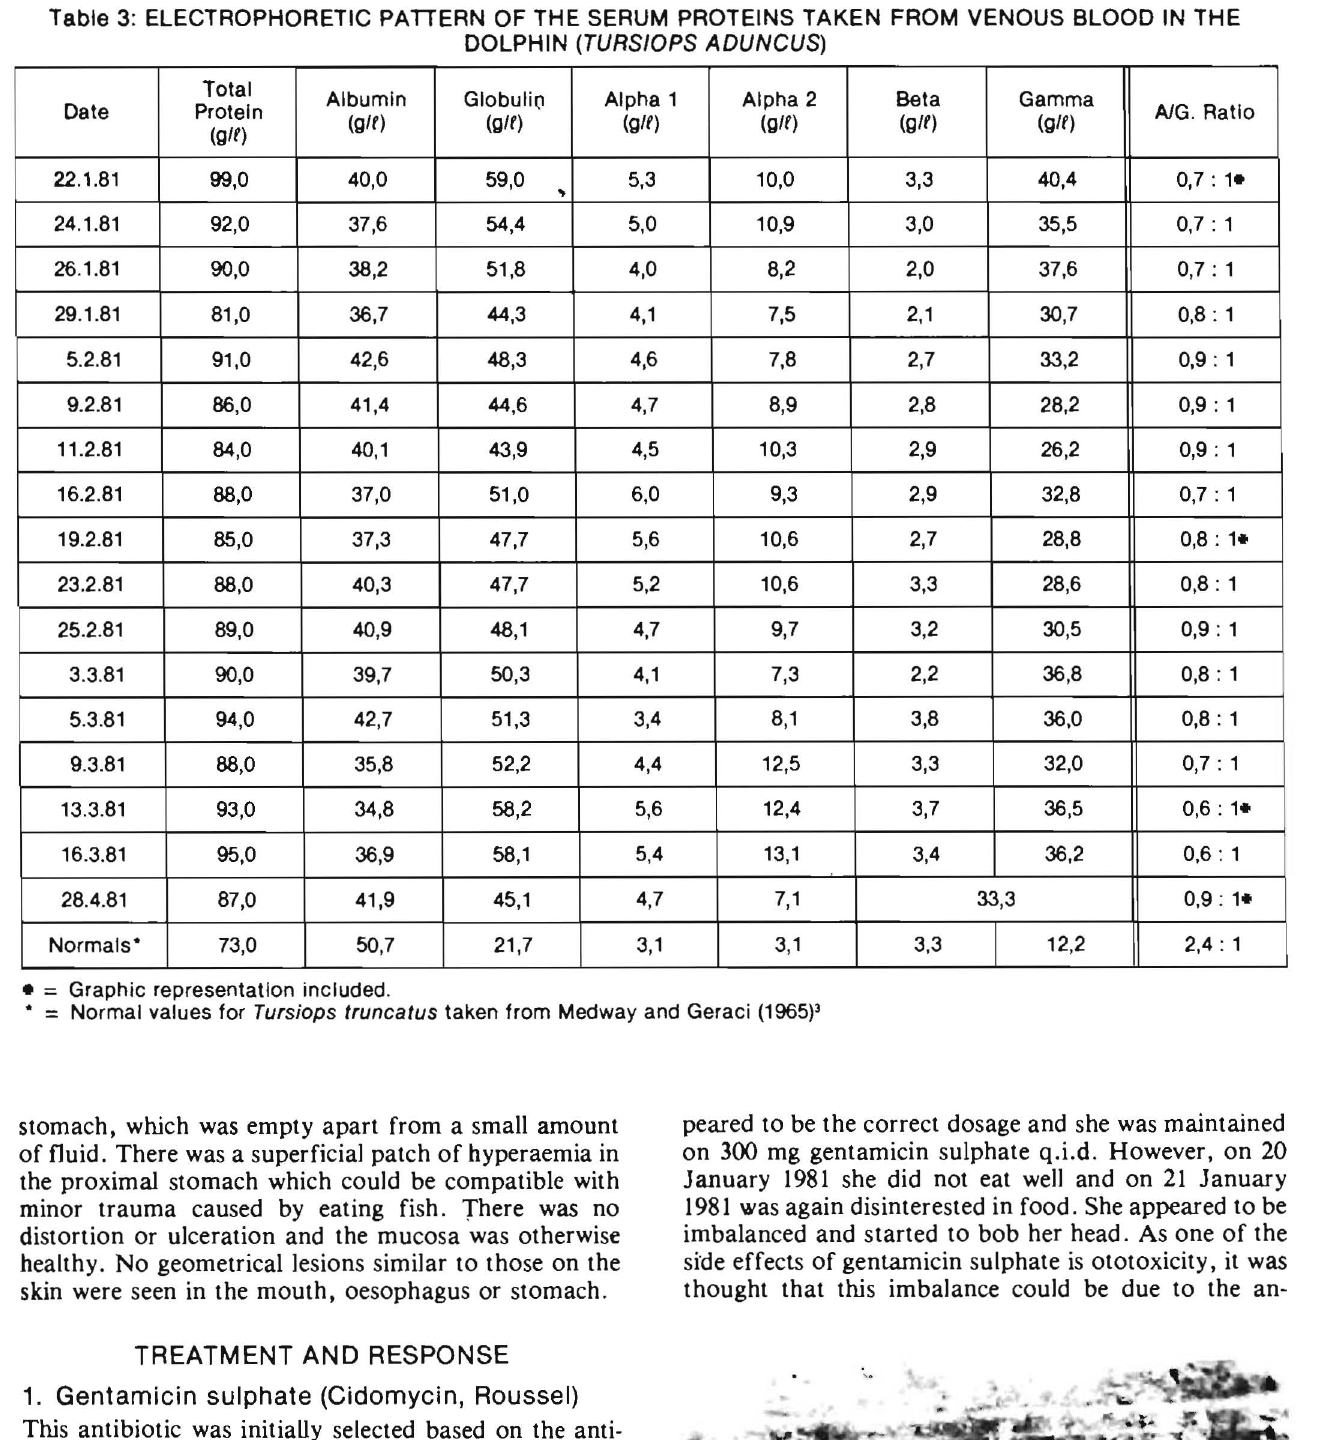
Table 3: ELECTROPHORETIC PATIERN OF THE SERUM PROTEINS TAKEN FROM VENOUS BLOOD IN THE DOLPHIN (TURSfOPS ADUNCUS) Total